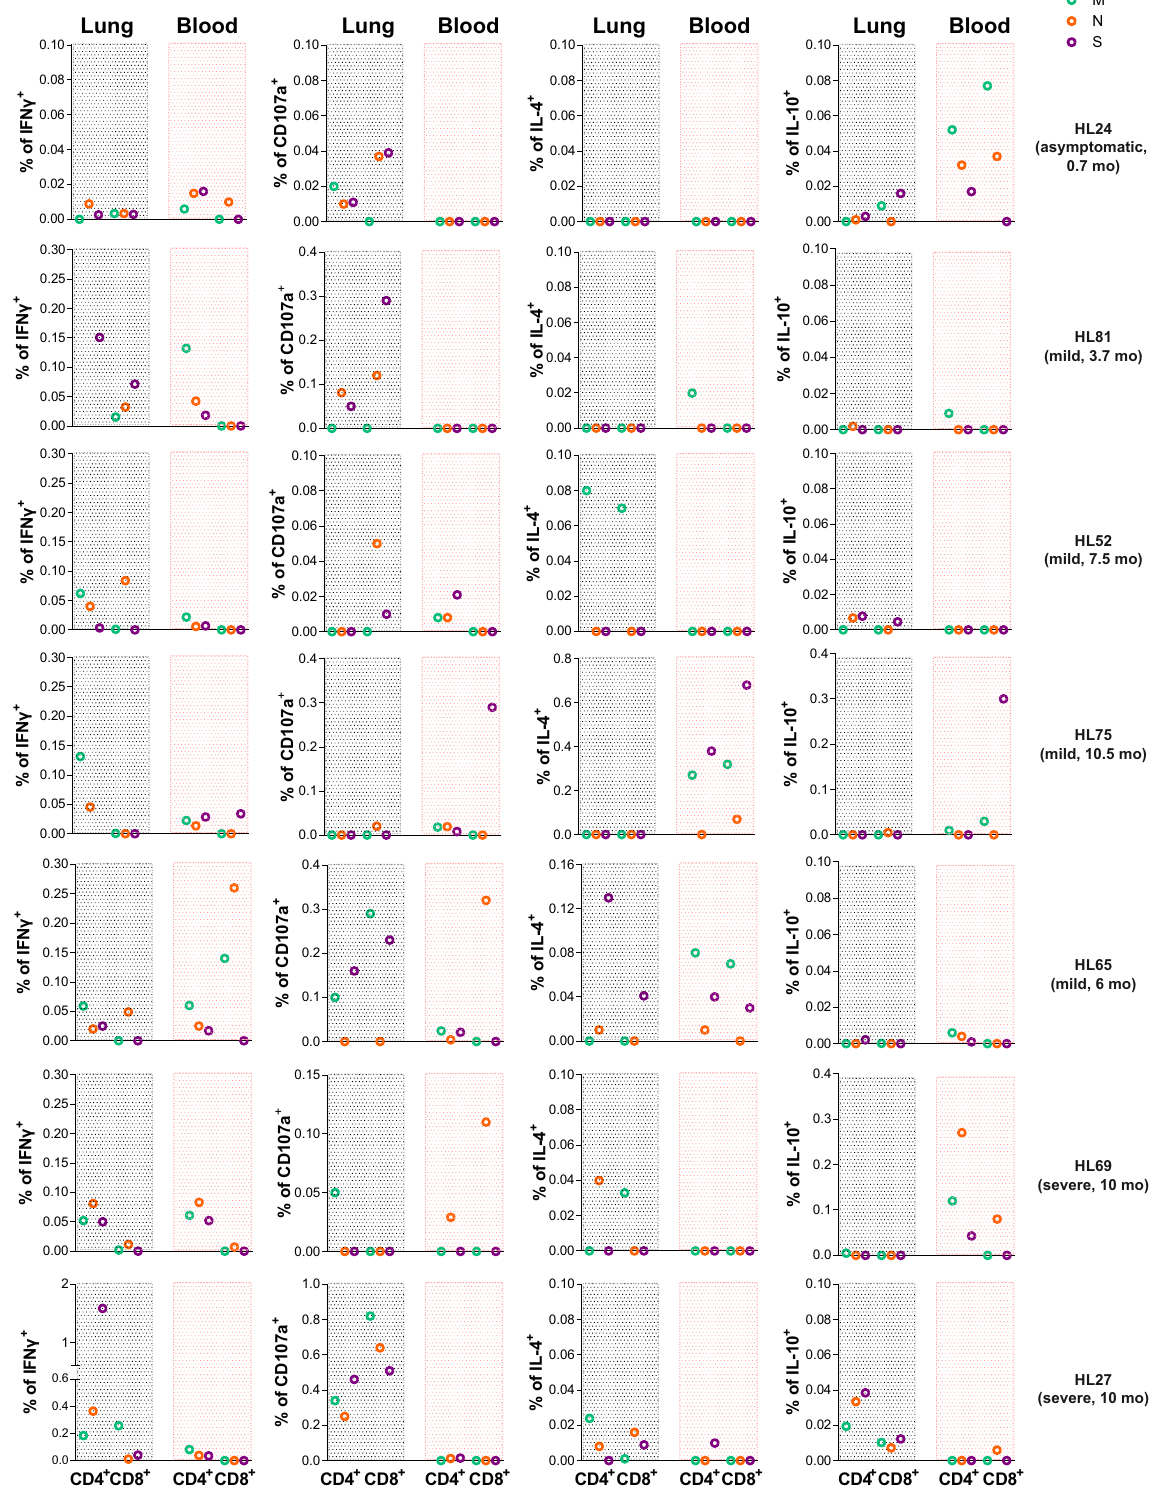
Fig. 7 SARS-CoV-2-speci fi c T cells in lungs and blood of convalescent patients. Total CD4 + and CD8 + T cell net frequencies of interferon (IFN) γ , CD107a, interleukin (IL)-4, and IL-10 expression in SARS-CoV-2-speci fi c T cells derived from lung or blood from the same patient. Each patient ( n = 7) is labeled on the right and includes disease pro fi le and sampling time: months (mo) after initial SARS-CoV-2 detection by PCR. Viral proteins are shown in color green (membrane protein, M), orange (nucleocapsid protein, N), and purple (spike protein,